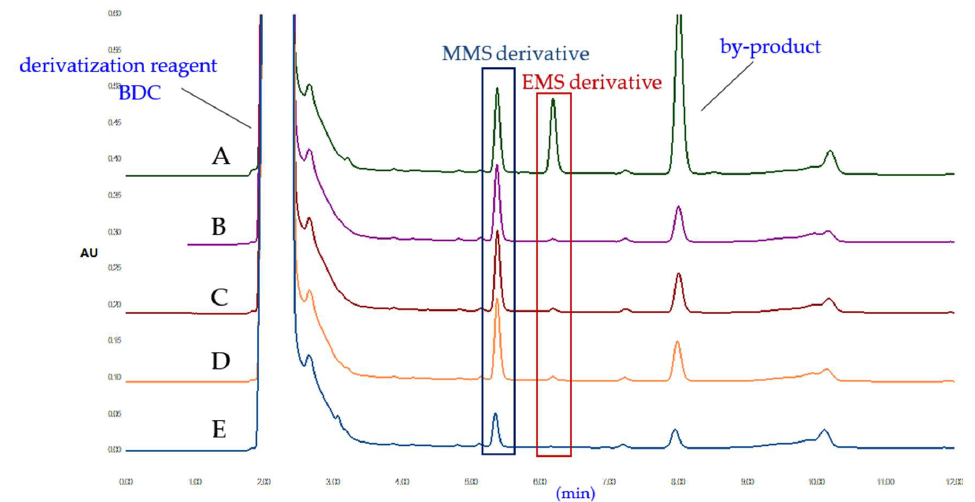
Figure 4. Chromatograms of the MMS and EMS derivatives in the different reaction conditions. ( A ) 80 °C 1 h; ( B ) ultrasonic 1 h; ( C ) light 1 h; ( D ) untreated 1 h; ( E ) untreated 0 h.